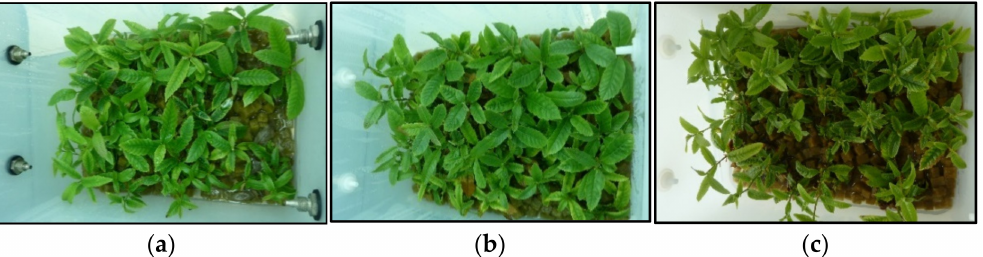
Figure 1. Chestnut shoots of clone CO53 after 8 weeks of culture by continuous immersion with 0.5%